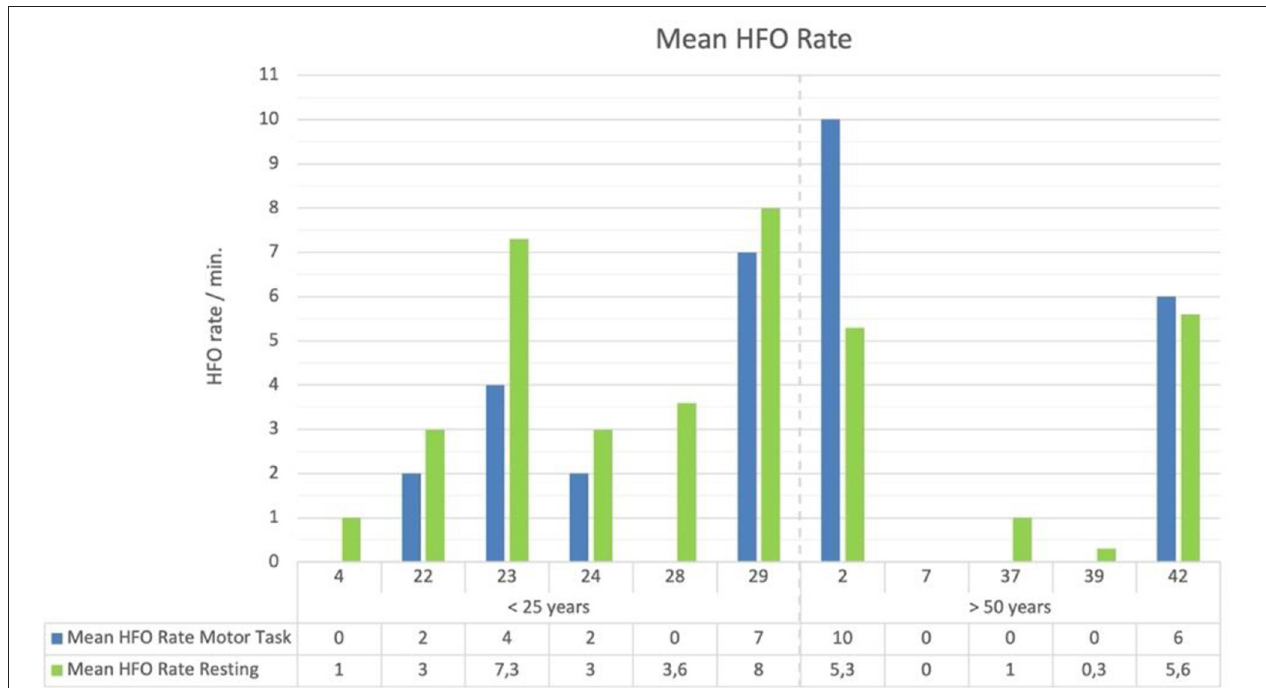
FIGURE 4 | Mean HFO rate split up for tasks and age-groups.